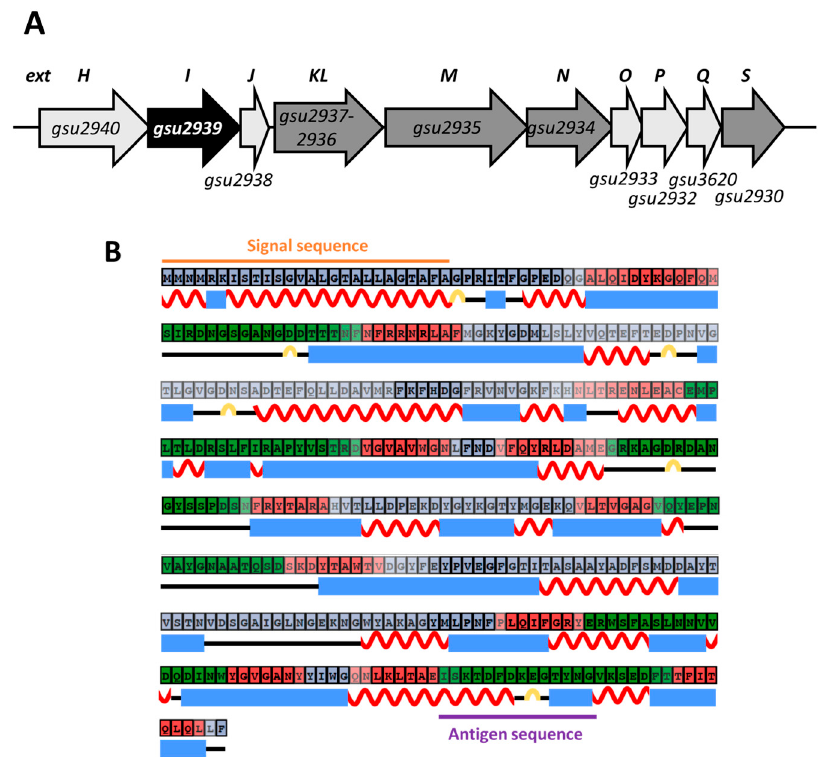
Figure 1. Bioinformatics analysis of ExtI. ( A ) The extHIJKLMNOPQS gene cluster in G. sulfurreducens . The black arrow indicates the gene for a porin-like protein, extI ( gsu2939 ), and the dark grey arrows indicate the genes for putative Cyt c proteins, extKL ( gsu2937-2936 ), extM ( gsu2935 ), extN ( gsu2934 ), and extS ( gsu2930 ). The light gray arrows indicate the genes for a rhodanese-like protein, extH ( gsu2940 ); a small protein, extJ ( gsu2938 ); a Rieske iron-sulfur protein, extO ( gsu2933 ); a cytochrome b , extP ( gsu2932 ); and a membrane protein, extQ ( gsu3620 ). ( B ) Prediction of the secondary structure of the ExtI protein. The amino-acid sequence of ExtI was computationally analyzed, and the secondary structure and the signal region were predicted. The N -terminal signal sequence (1–26 a.a.) predicted by SignalP 4.1 and the transmembrane α -helix region in the signal sequence (7–26 a.a.) predicted by TMHMM are depicted. Amino-acids in red, green, and gray boxes are predicted to be transmembrane, extracellular side, and periplasmic side, respectively. Red wavy lines, blue squares, and yellow lines represent α -helices, β -strands, and turns, respectively. The purple line shows the peptide sequence of the antigen used for preparation of the anti-ExtI antibody.